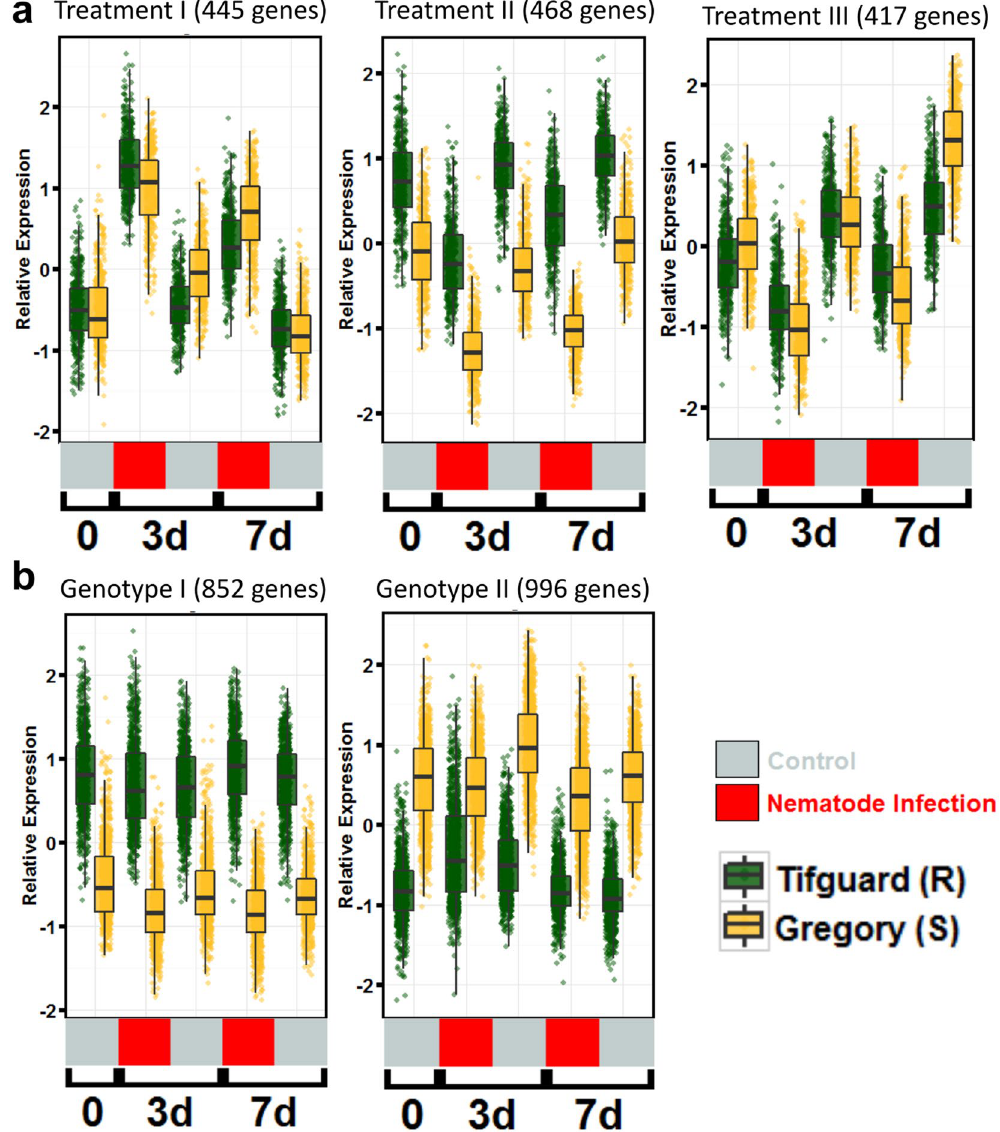
Figure 2. Co-expression clusters of significantly expressed genes affected by treatment and genotype. (a) Clusters representing genes affected by treatment (nematode infection). ( b) Clusters representing genes affected by genotype. Jitter boxplots representing Z-score transformed relative expression of differentially expressed genes in each cluster. Boxplots represent median relative expression, first quartile (bottom of box), third quartile (top of box), and maxima. The actual spread of the data is represented by jittered dots so the relative expression of every individual gene is represented on the plot. Uninoculated control (silver) samples and samples inoculated with 20,000 juvenile Meloidogyne arenaria (red) and harvested at 3 days (3d) and 7 days (7d) after